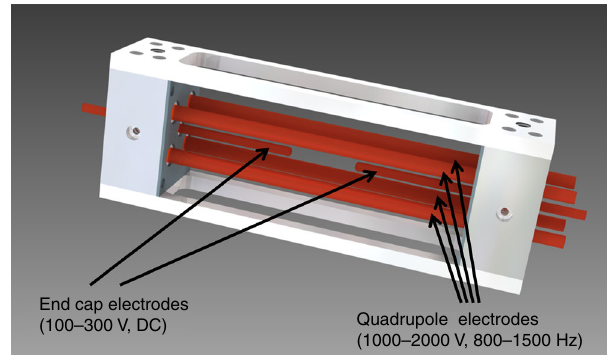
Fig. 7 Schematic representation of waveform aberrations induced by